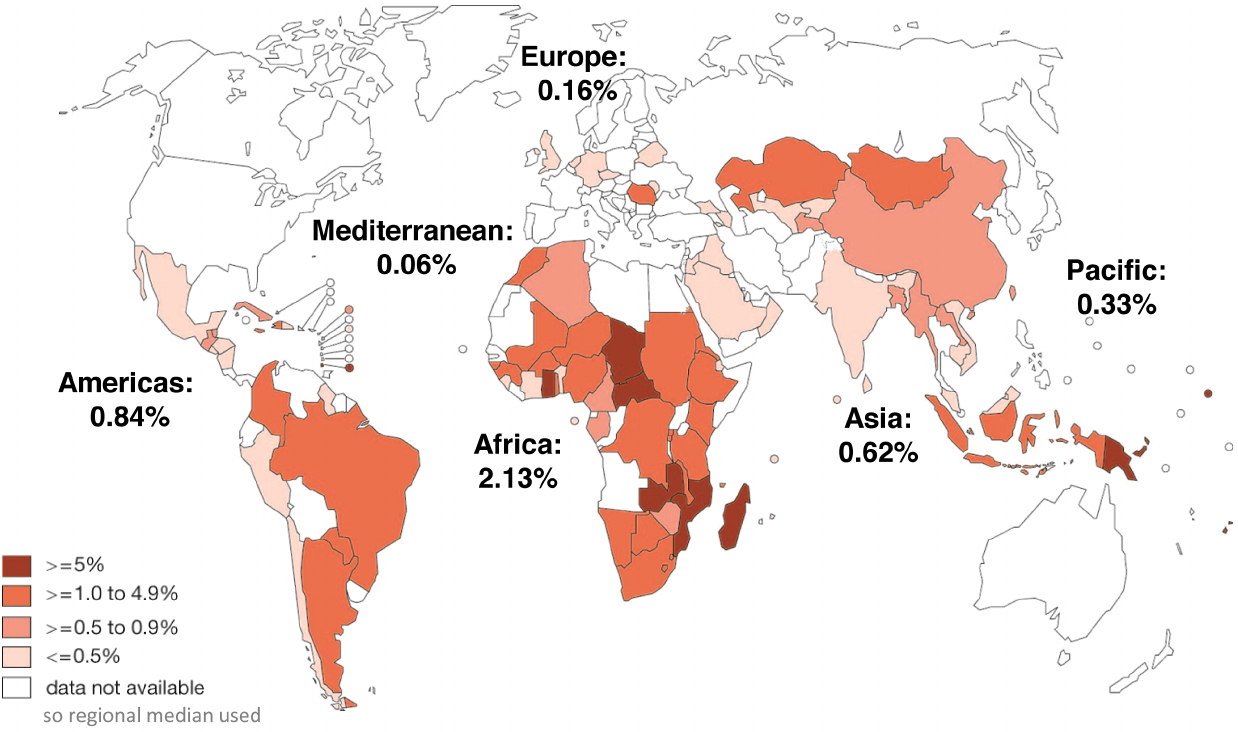
Figure 2. Syphilis seropositivity among antenatal care attendees reported by countries through the WHO HIV Universal Access reporting system in 2008 or 2009, and regional median for non-reporting countries.